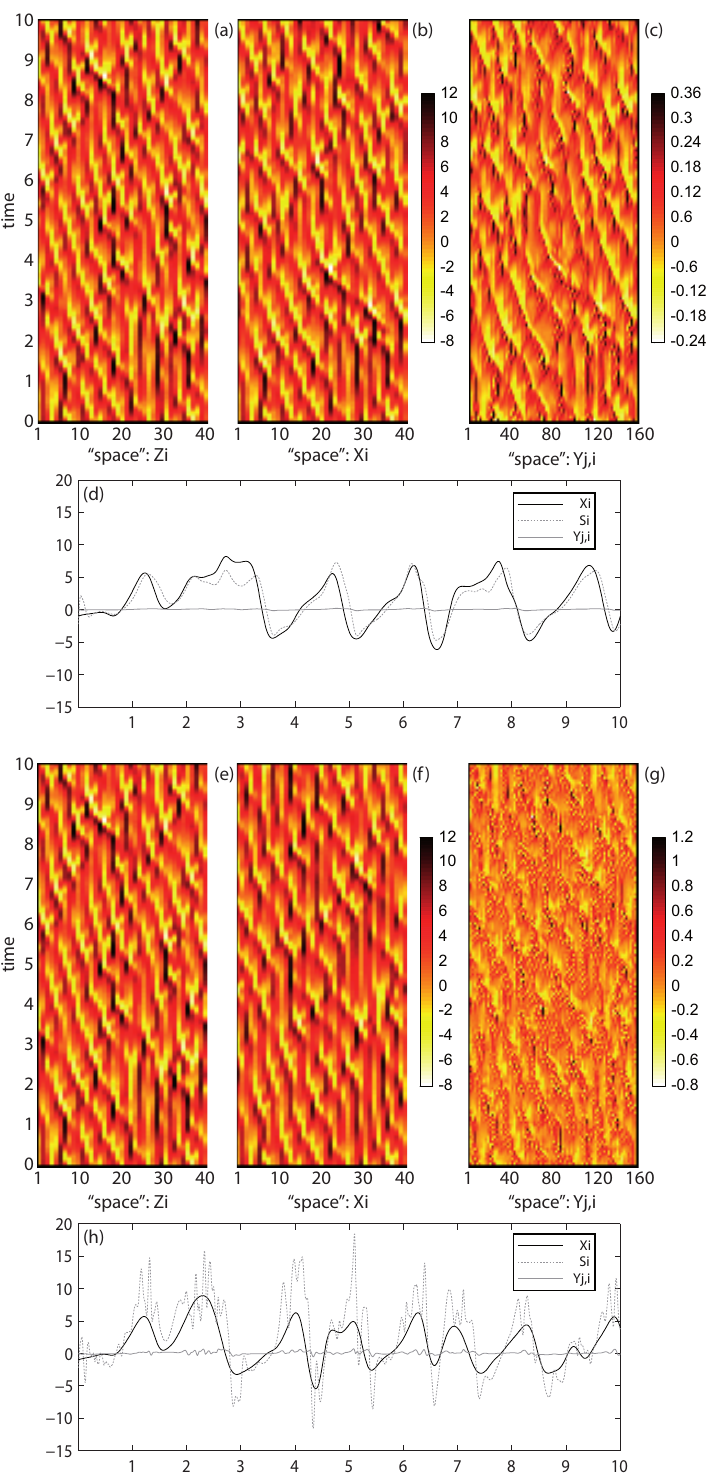
Fig. 2. Comparison of the trajectories of the simplified (Eq. 2) and two-scale (Eq. 1) L96 models with weak and strong coupling parameters; all integrated forward in time from the same initial conditions. The panels show the trajectories of the one-scale model (a, e) , the slow (b) and fast (c) variables of the two-scale model with weak coupling h =0.3 and the time evolution (d) of a single point in space ( i = 1) in the slow variable (black line), in one of the fast variables associated to this point (gray line) and the contribution of the fast variables to this point at each time (dotted line). Panels (f–h) are equivalent to (b-d) but for the case of strong coupling h =1. Note that panels (a) and (e) are identical in order to facilitate a visual comparison between patterns in each row. Notice also the different scales used to depict slow and fast